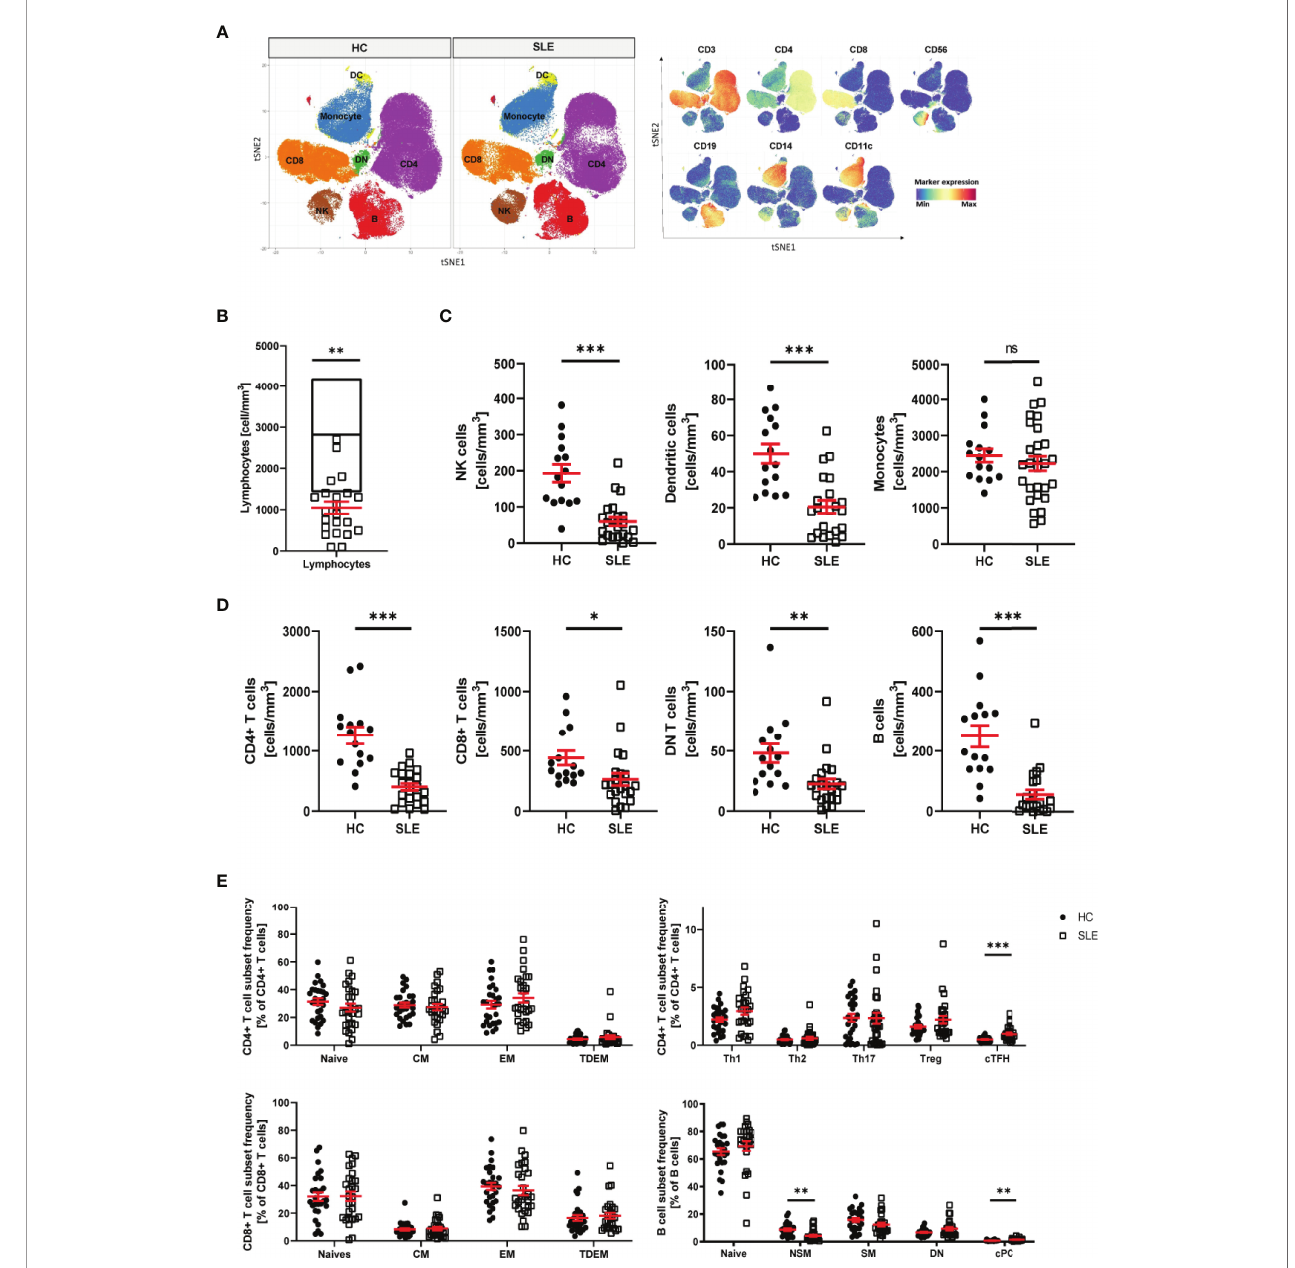
FIGURE 1 | Distribution of PBMC in SLE patients. (A) T-stochastic neighboring embedding analysis of main PBMC populations on 3 representative SLE patients (with active disease) and mean expression of lineage markers (blue: low expression, red: high expression). (B) Lymphocyte abundance in SLE patients (n=22) compared to normal healthy range (represented as median with interquartile range of HC n=15, Student T-test, **p=0.007). (C) Abundance of innate immune cells in peripheral blood of SLE patients compared to HC (Welch ’ s T test, NK cells (HC n=15, SLE n=22, ***p<0.001), DC (HC n=15, SLE n=22, ***p<0.001), monocytes (HC=15, SLE n=28, ns p=0.46). (D) Abundance of adaptive immune cells in peripheral blood of SLE patients compared to HC (Welch ’ s T-test, CD4+ T cells (HC n=15, SLE n=22, ***p<0.001), CD8+ T cells (HC n=15, SLE n=22, **p=0.03), DN T cells (HC n=15, SLE n=22, **p=0.009), B cells (HC n=15, SLE n=21, ***p<0.001). (E) Frequency of CD4+ T, CD8+ T and B cell subpopulations in HC and SLE patients (HC n=28, SLE n=28, Welch ’ s T tests on log10 transformed data, cTFH p<0.001, NSM p=0.004, cPC Mann-Whitney test, p<0.001). Healthy controls (HC), Systemic lupus erythematosus patients (SLE), double negative (DN), natural killer (NK) cells, dendritic cells (DC), central memory (CM) cells, effector memory (EM) cells, terminally differentiated effector memory (TDEM) cells, T helper (Th) cell, T regulatory (Treg) cells, circulating T follicular helper (cTfh) cells, non switch memory (NSM) cells, switch memory (SM) cells, circulating plasma cells (cPC). Data represent mean ± SEM (*p = 0.02, **p = 0.02, ***p < 0.001, ns not signi fi